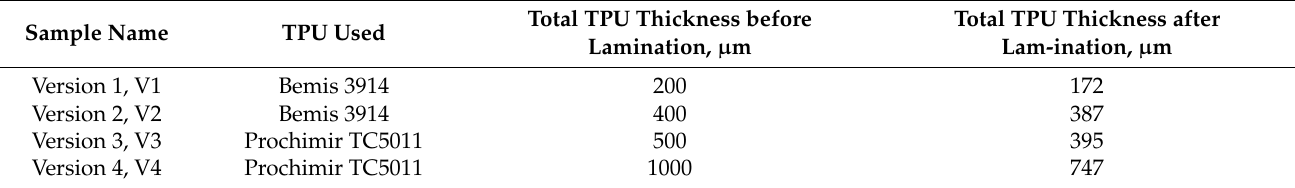
Table 3. Samples